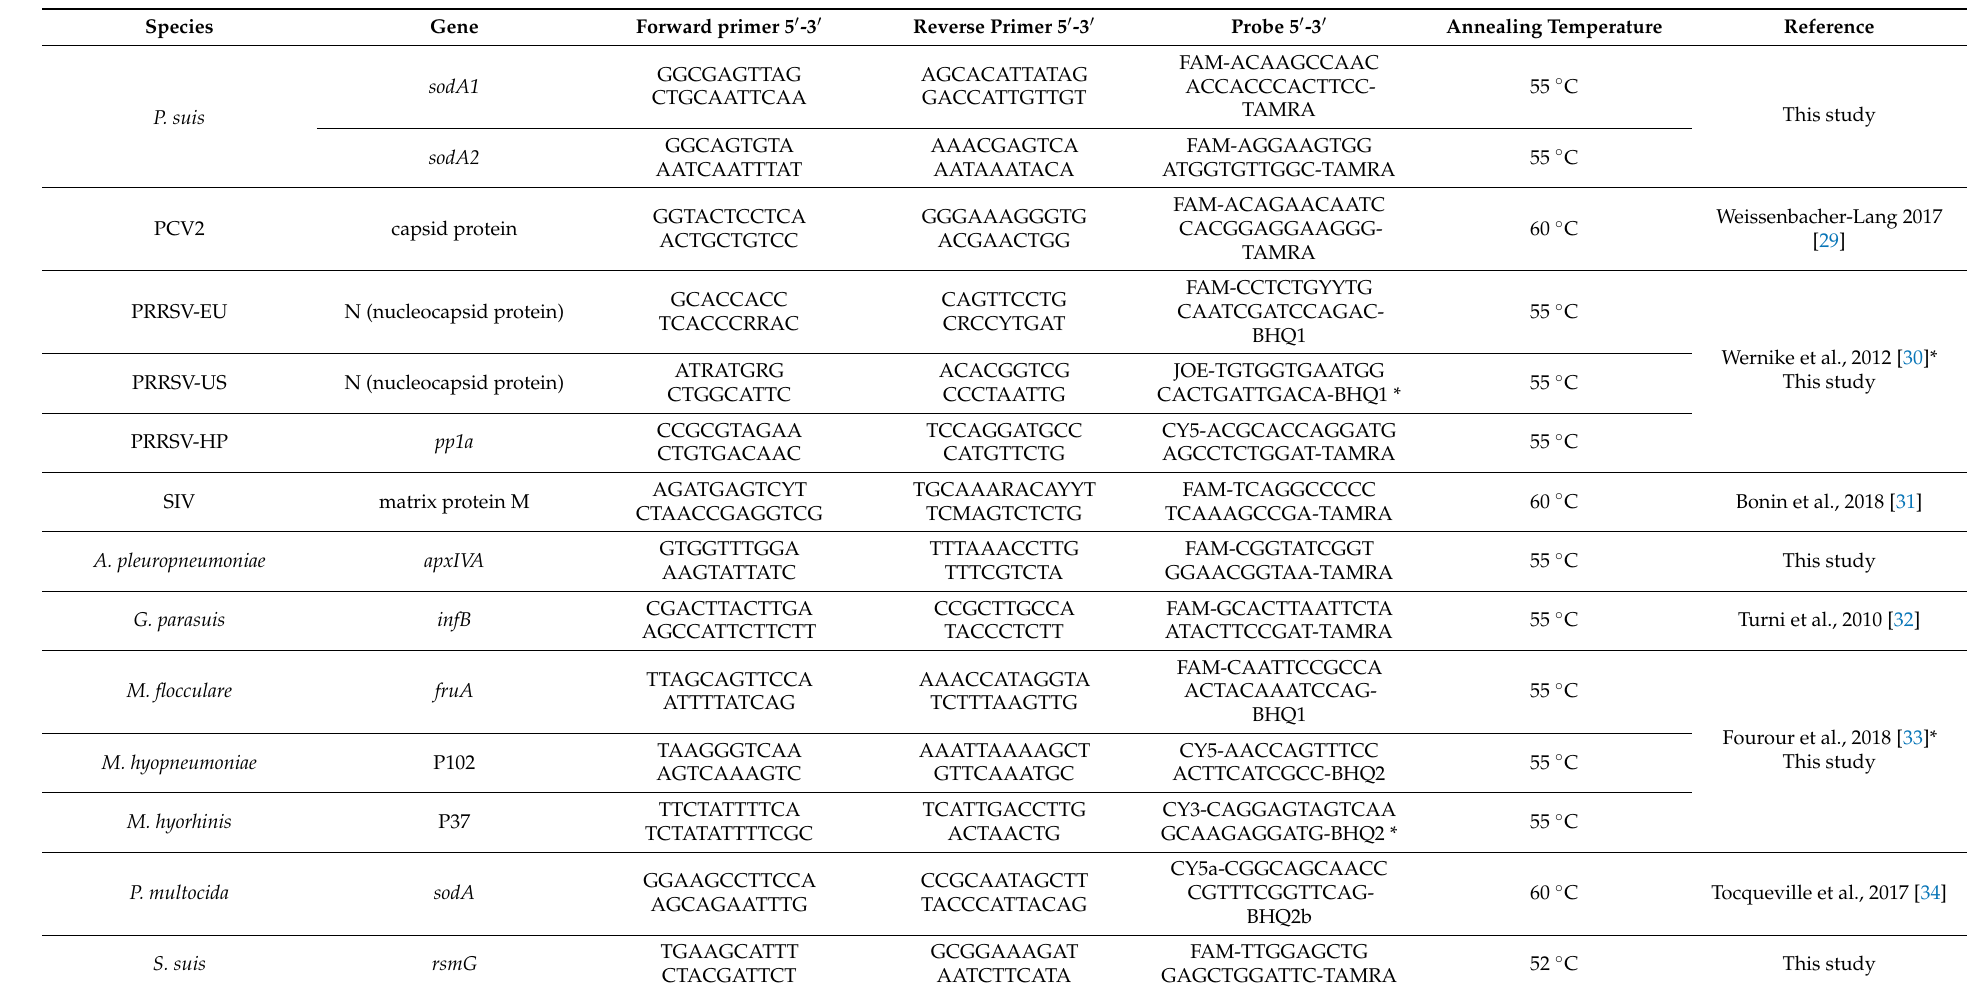
Table 1. Primers and probes used in the current